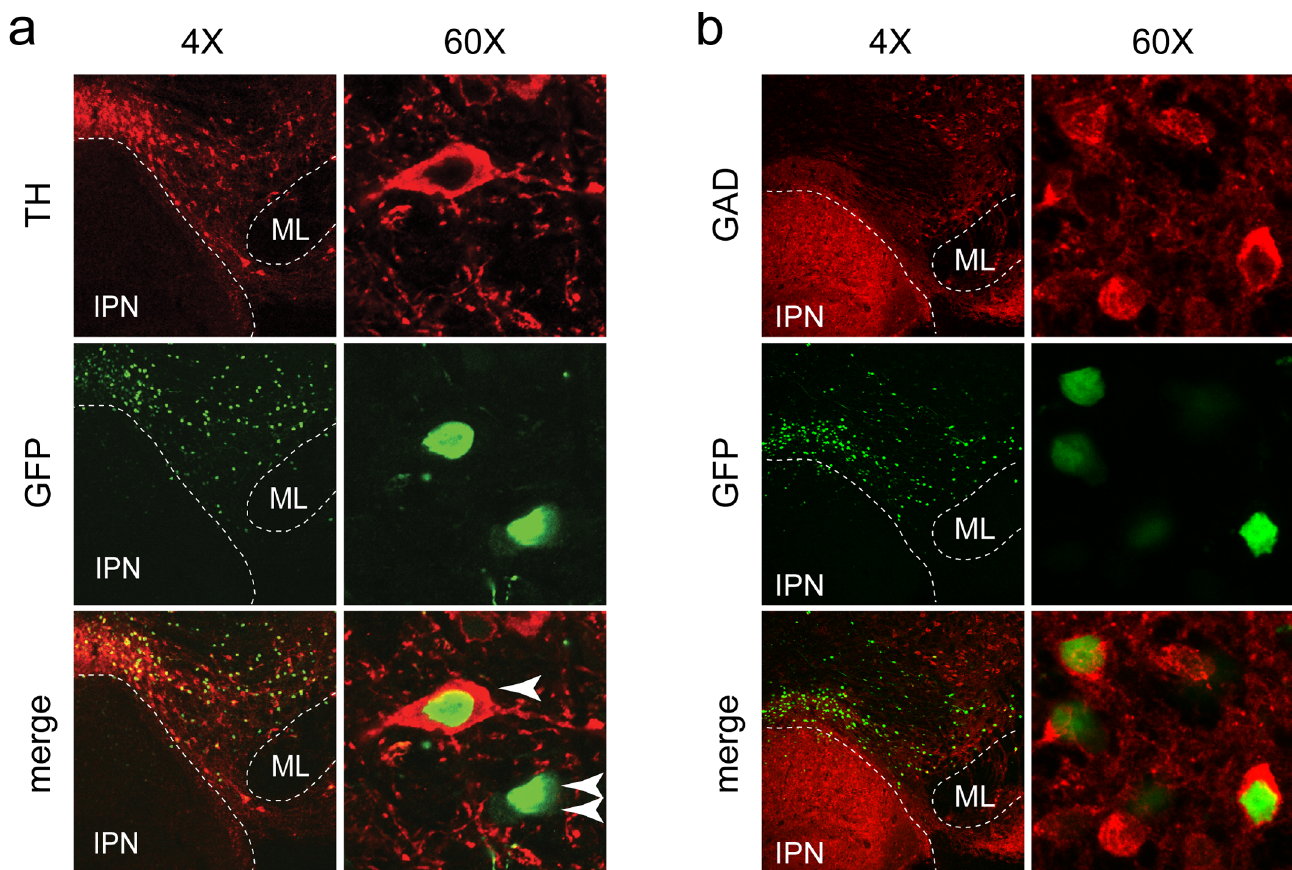
Fig 6. Cre virus infection of VTA DA and GABA neurons. a) Targeting the VTA with AAV vectors. Mice were infusedinto the VTA with AAV-Cre- GFP vectors. After 2–3 weeks, mice were perfused and brainswere sectionedfor immunohistochemistry. Anti-GFP stainingidentifies infected neurons, whileanti-TH stainingidentifiesDA neurons. High magnification (60X) images show Cre-GFP expressionin TH(+) and TH(-) neuronsin VTA, indicatedby one or two arrows, respectively. IPN: interpeduncularnucleus,ML: mediallemniscus.b) Cre recombinase expressionin VTA GABA neurons. Slices from the infectionshown in (a) were stainedwith anti-GAD65/67 antibodies. Native GFP signal was imagedwithout anti-GFP staining.